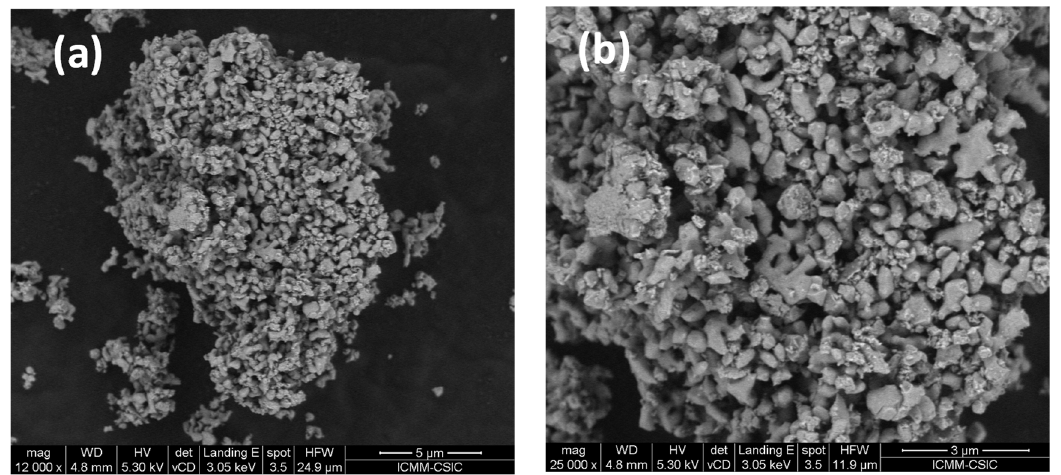
Figure 12. ( a ) 12,000× and ( b ) 25,000× SEM micrographs of SrMo 0.9 Al 0.1 O 3 − δ sample showing an ex- cellent porosity. The typical particle size is below 1 μ m, although groups of several particles sin- tered together are